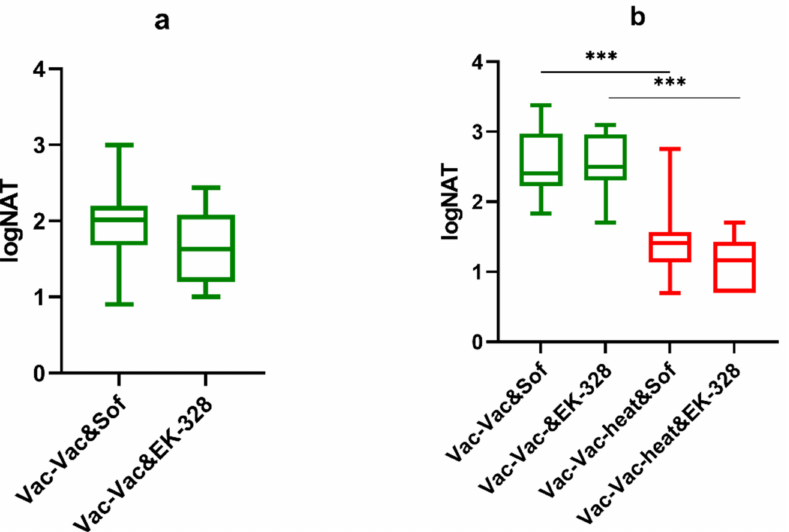
Figure 6. NAb titers in vaccinated BALB/c mice against two TBEV strains Sofjin and EK-328 ( a ) after the second vaccine dose ( b ) on day 2 after the virus challenge with TBEV EK-328 strain (green) (n = 7–8) (Vac-Vac) and TBEV EK-328 strain heated at 37 ◦ C for 48 h (Vac-Vac-heat), red) (n = 7–8). The virus infection dose was equalized to 30 LD 50 per mouse for both groups. *** p < 0.001 obtained by Mann-Whitney test. Box plots indicate median and range.